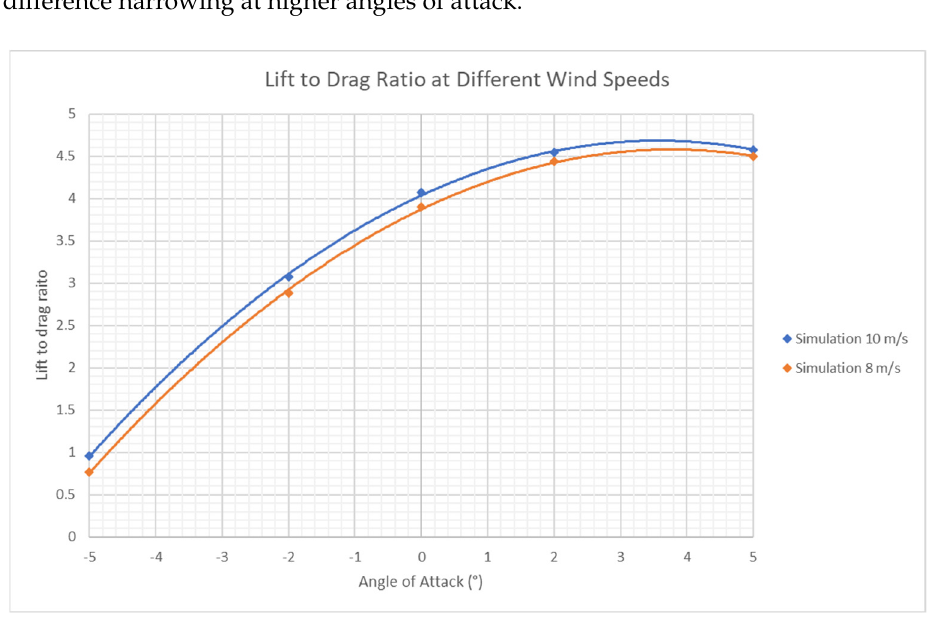
Table 5. Coefficient of performance calculation method comparison.